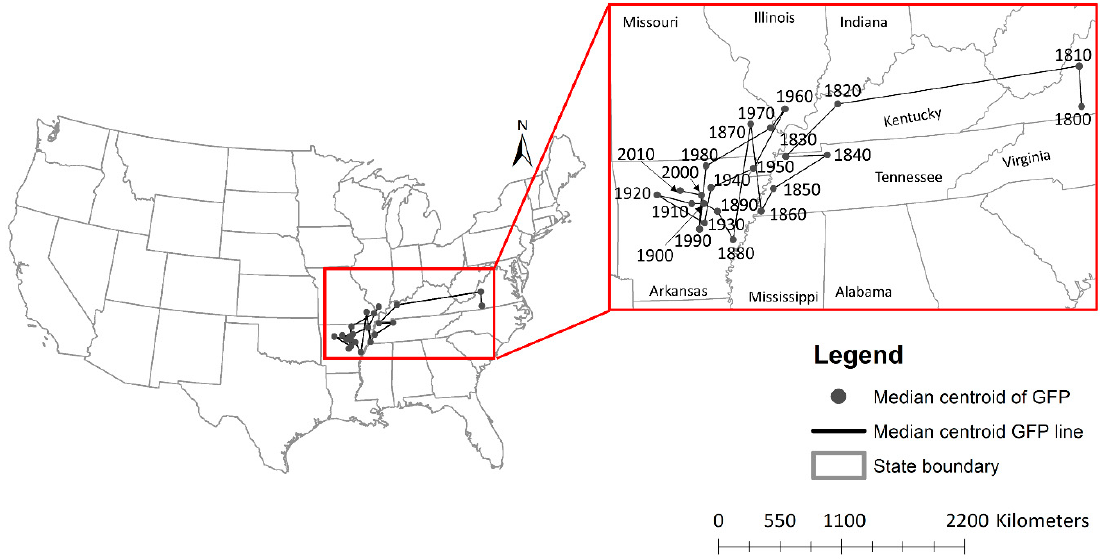
Figure 2. Spatial distribution of the centroids of the growth rate of floodplain population (GFP) from 1790 to 2010.